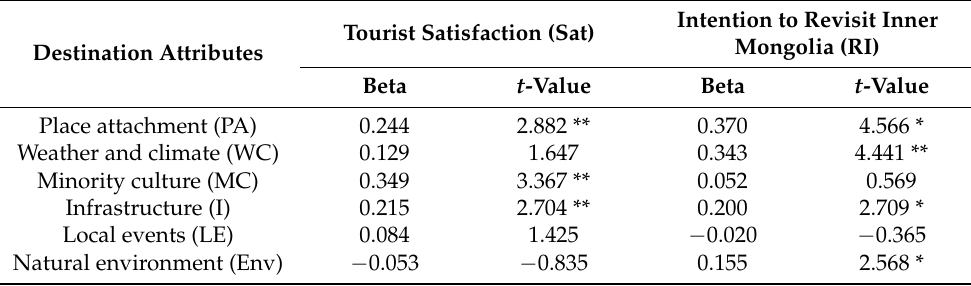
Table 4. Determination of destination